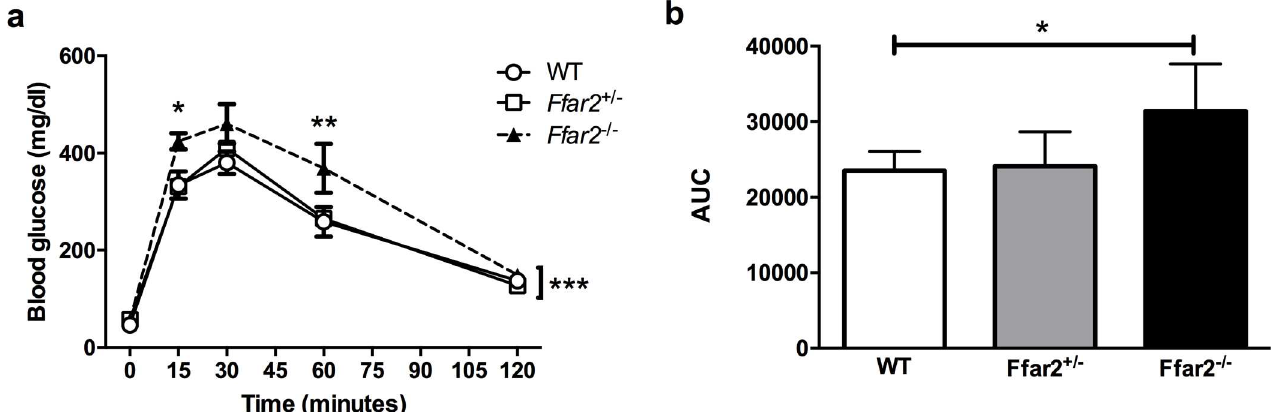
Fig 1. Ffar2 +/- mice exhibit normal glucose tolerance at gestational day 15 (G15). ( a ) Plasma glucoseconcentrations from WT, Ffar2 +/- and Ffar2 -/- female mice duringan IPGTT at G15. ( b ) The correspondingarea under the curve (AUC) for the IPGTT. WT circles and white bars; Ffar2 +/- , squaresand gray bars; Ffar2 -/- , trianglesand black bars. Data in (a) were comparedby 2-way ANOVA with Bonferroni post-hoc analyses. Data in (b) were comparedby Student’s t-test ( * , p < 0.05; ** , p < 0.01; *** p < 0.001), n = 4–5 mice/ group.